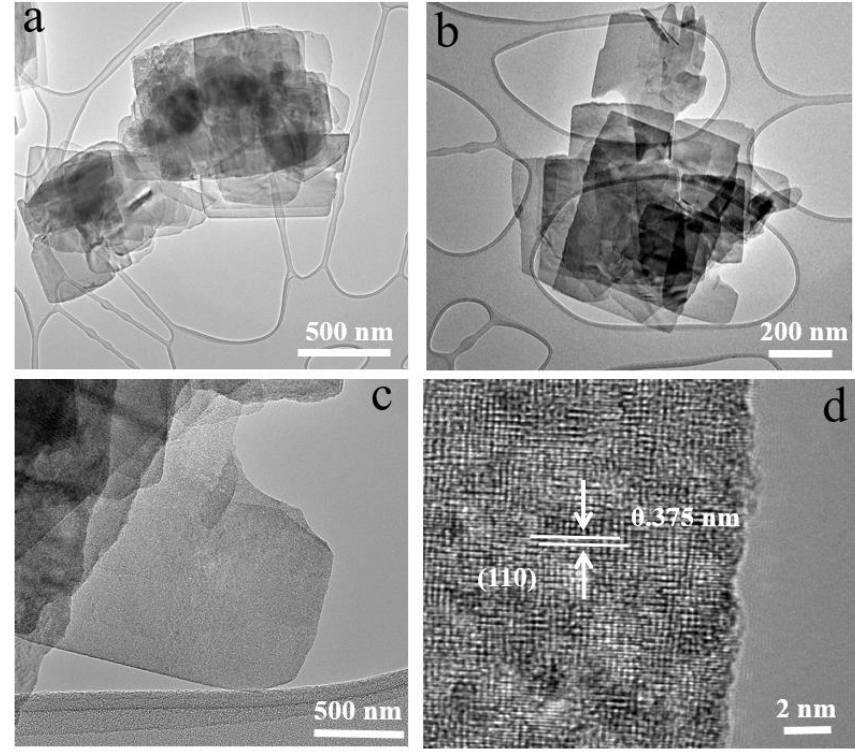
Figure 2. ( a – c ) The TEM images and ( d ) HRTEM image of Cu doped MoO 3 nanosheet. Figure 2. ( a–c ) The TEM images and ( d ) HRTEM image of Cu doped MoO 3 nanosheet.